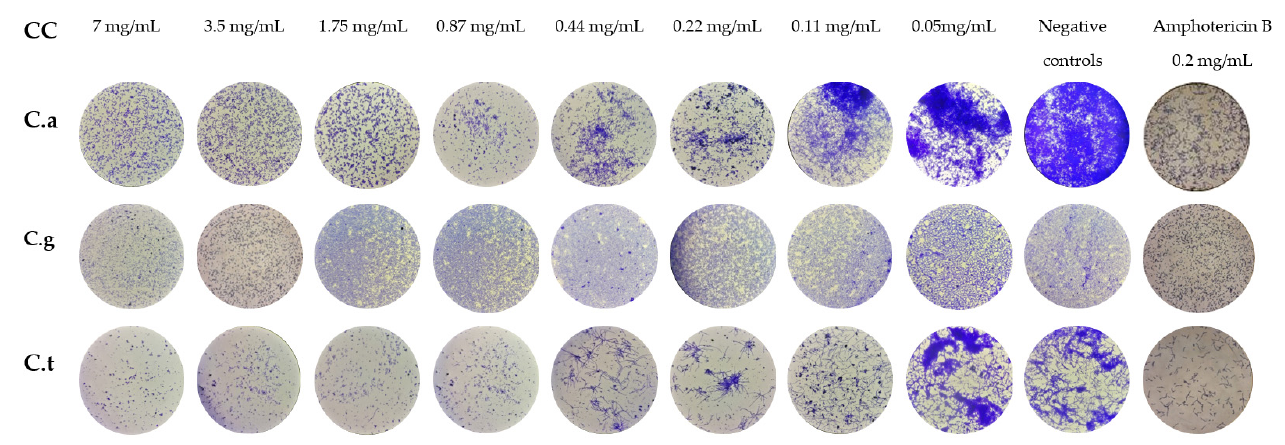
Figure 5. Micrographs of Candida spp. cells treated with various concentrations of VF2 for Inhibition of Biofilm Formation (IBF). CC: Concentration, C.a: Candida albicans , C.g: Candida glabrata . C.t: Candida tropicalis.